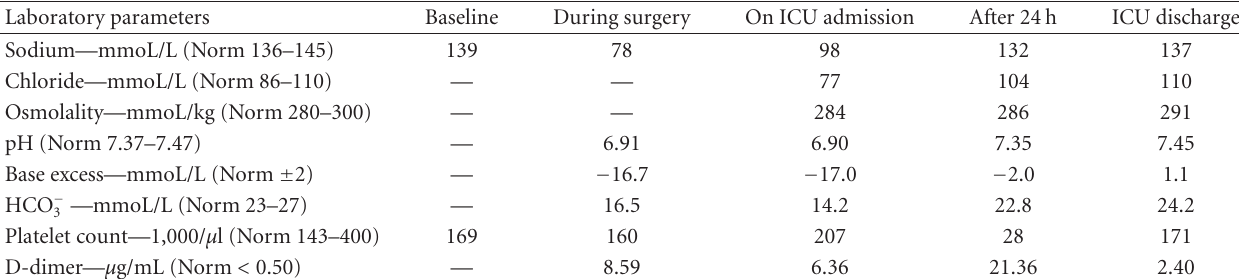
Table 1: Laboratory